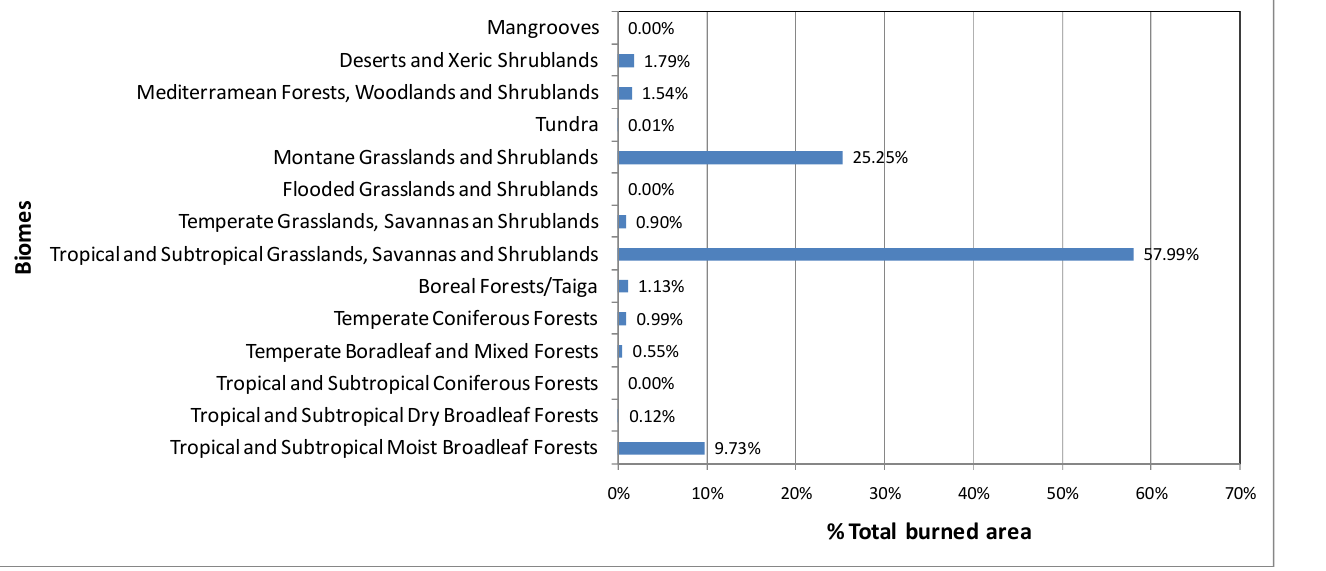
Figure 10. Total burned area per biome in percentages estimated after overlaying the sampling scenes with Landsat fire perimeters as mapped using the rule-based approach.